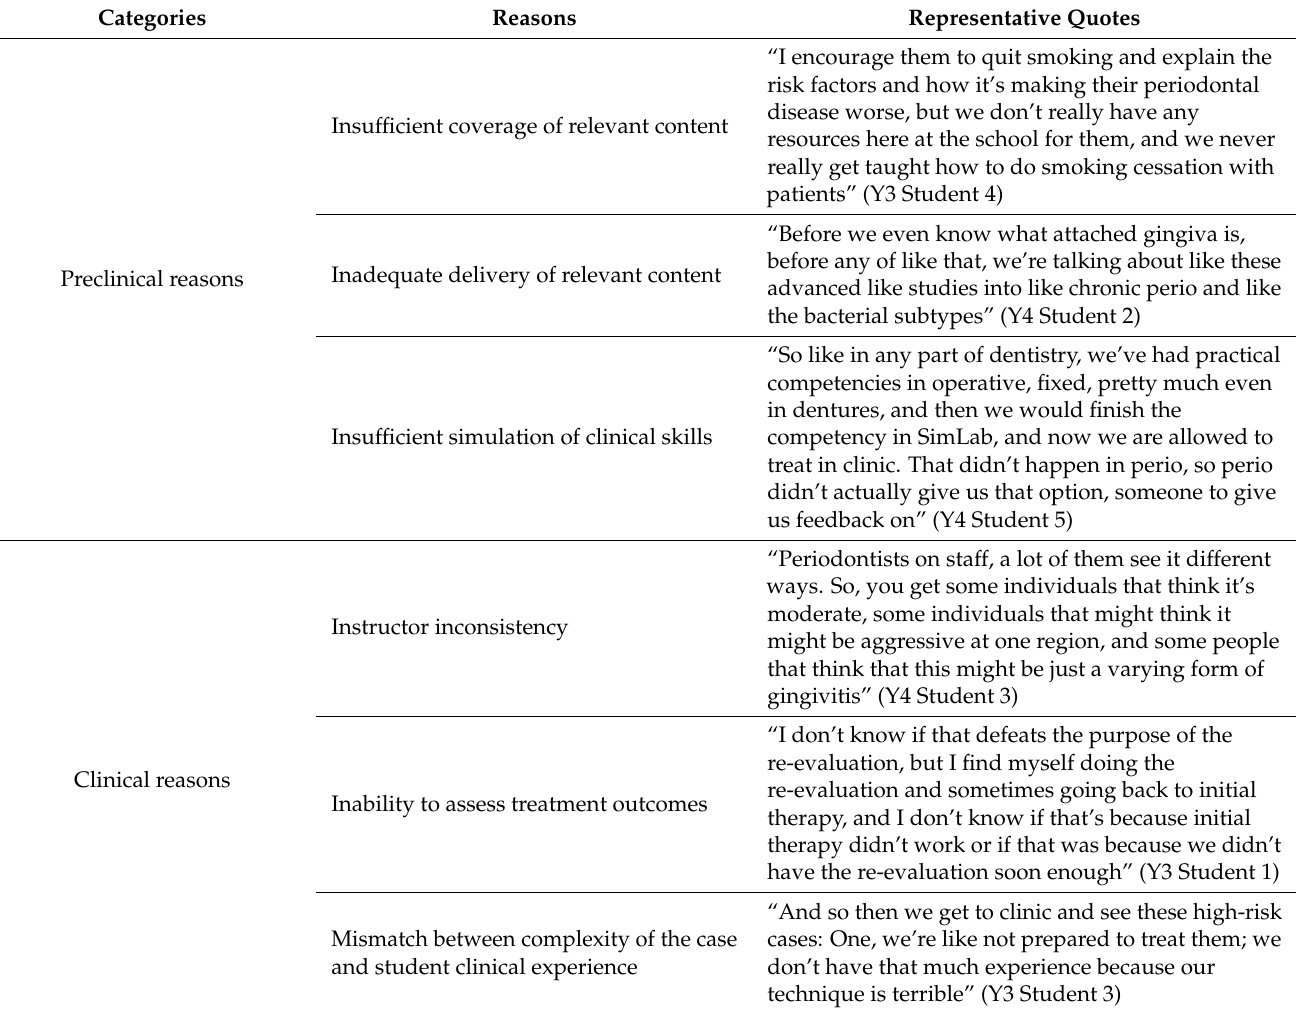
Table 3. Reasons for difficulties in periodontal